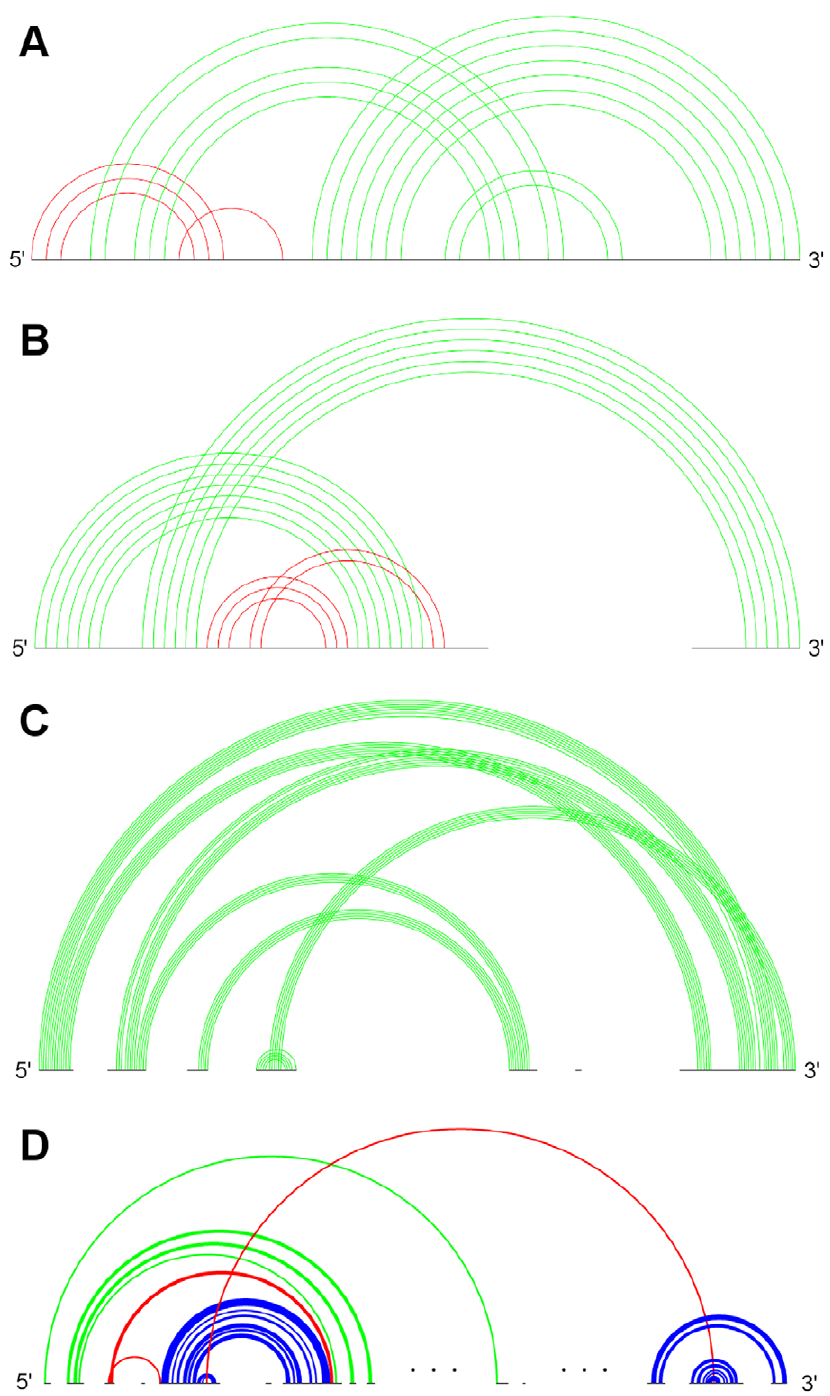
Figure 4. Typical sample structures for all genus 2 subclasses . A: RNA sequence CRW_00474 of subclass 2A with pseudoknot pattern ABCACDBD. B: RNA sequence PDB_00335 of subclass 2B with pseudoknot pattern ABCDCADB. C: RNA sequence ASE_00204 of subclass 2C with pseudoknot pattern ABCDEDBCAE. D: RNA sequence PDB_00187 of subclass 2D with pseudoknot pattern ABCBDEDCAFEF. (Stem color, blue: major stem; green: intermediate stem; red: minor stem).